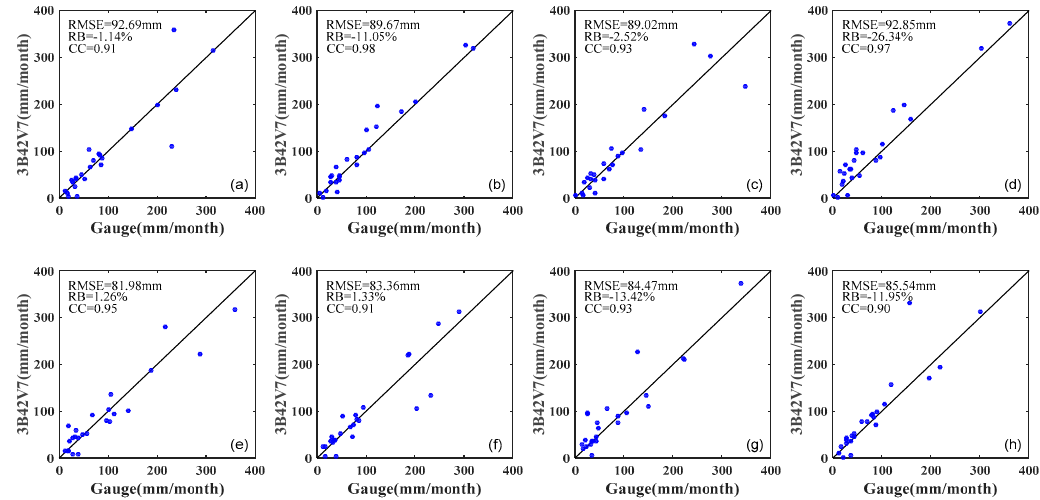
Figure 8. Scatter plots of monthly rainfall from rain gauge data and 3B42V7 (( a – h ) indicate that the gauge ID in Table 1).